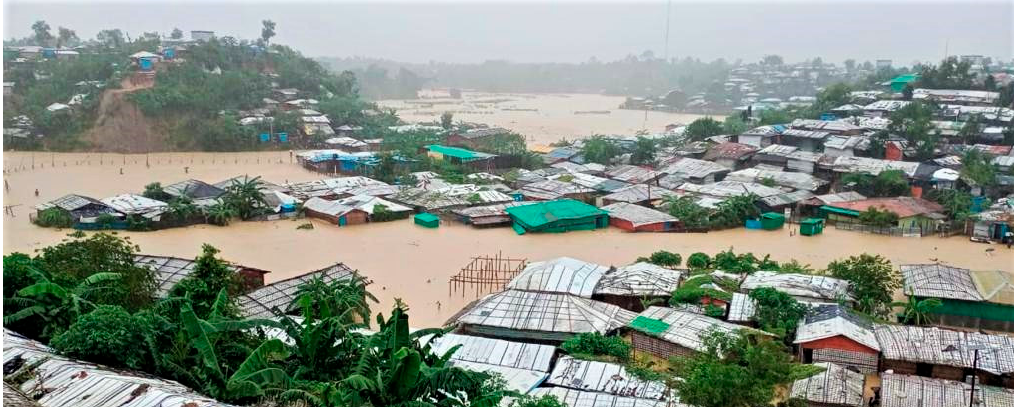
Figure 3. Rohingya refugee camp Bangladesh.